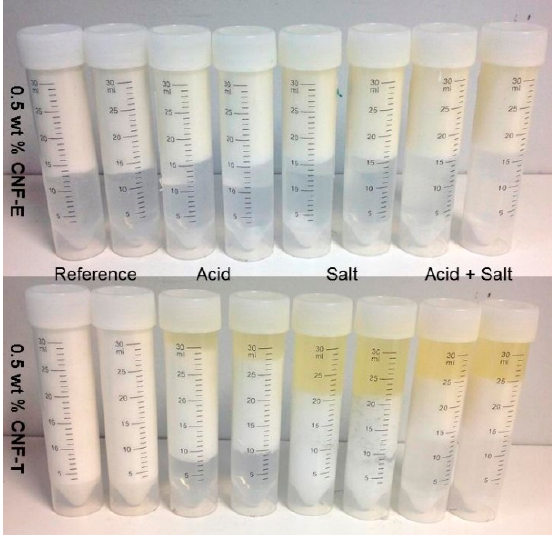
Figure 5. Pictures of emulsions stabilized by CNF-E (upper) or CNF-T (lower) with the addition of acetic acid and NaCl, taken after centrifugation, with two replicates for each sample.